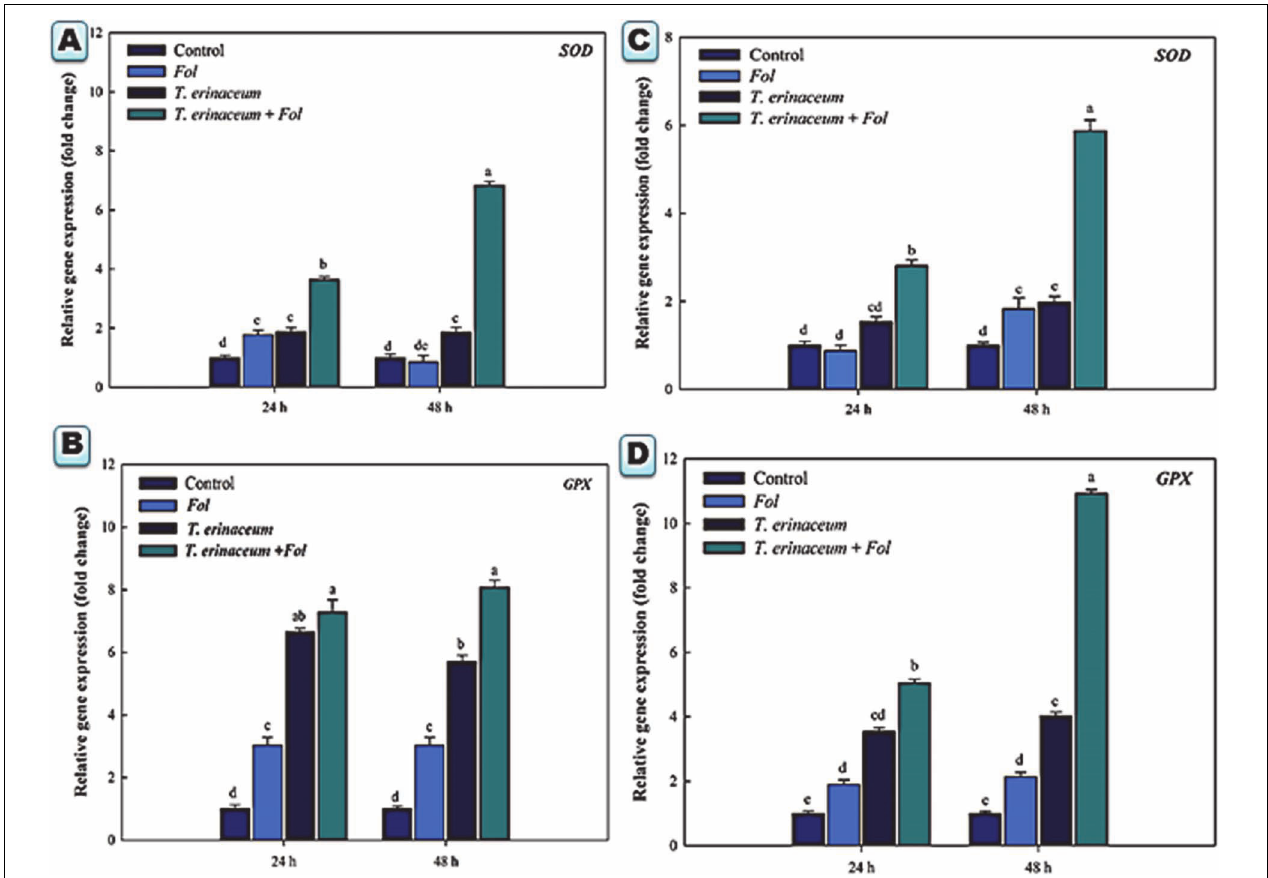
FIGURE 5 | Quantitative PCR results showing the tissue specific differential expression profile changes of the Cu-Zn SOD and glutathione peroxidase encoding gene SlGPX1 genes expressed in the root and leaf tissues and were measured at time intervals (0, 24, and 48 h) in each of the four different treatments. The data represents the relative fold changes in the expression values for the four different treatments. (A) The expression profile of the SOD gene in the root tissues. (B) The expression profile of the SlGPX1 gene in the root tissues. (C) The gene expression profile of the SOD gene in leaf tissues. (D) The expression profile of the SlGPX1 gene in leaf tissues. Bars with distinct alphabetical letters are significantly different at P ≤ 0.05 using the DMRT